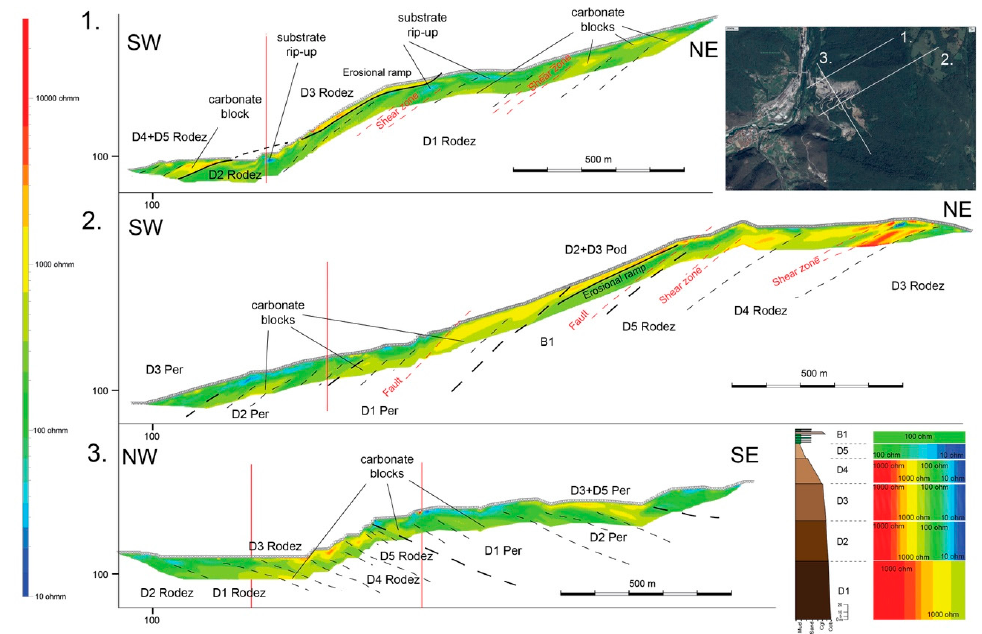
Figure 5. Interpreted ERT profiles with locations and stratigraphic subdivision into ERT facies on the basis of the observed resistivity ranges with the backup of surface observation. The red vertical lines indicate the profile